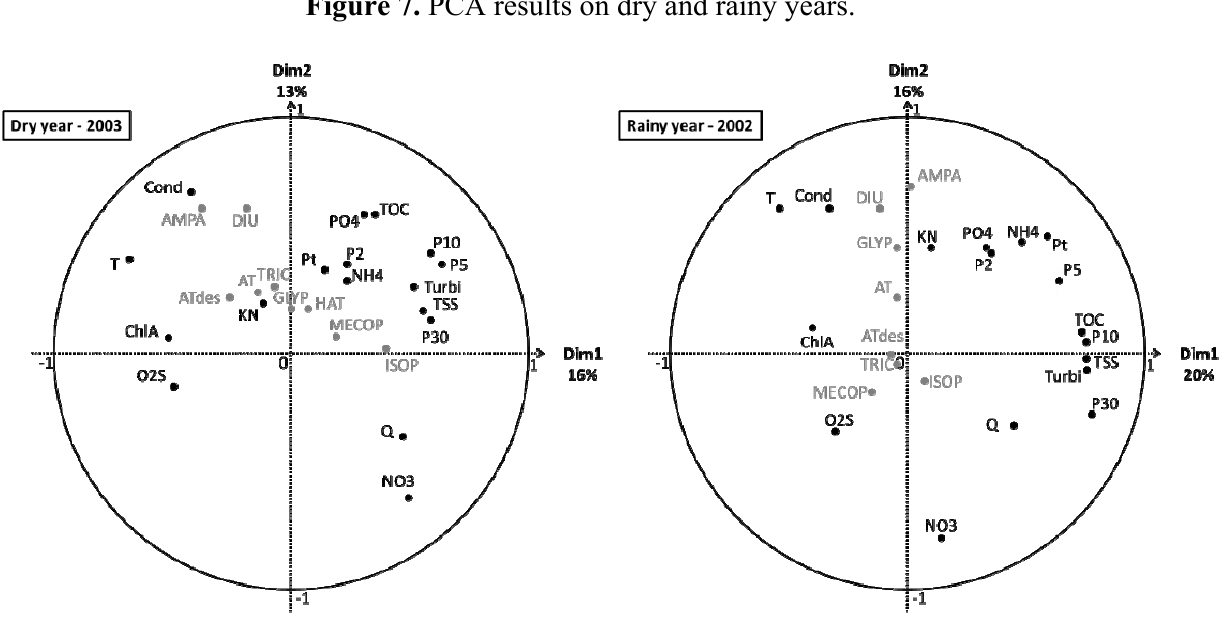
Figure 7. PCA results on dry and rainy